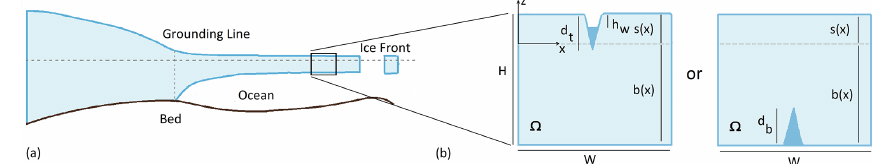
Figure 1. Cross-section geometry of a marine ice sheet and the geometry of the problem: part of a floating ice shelf with a surface or bottom